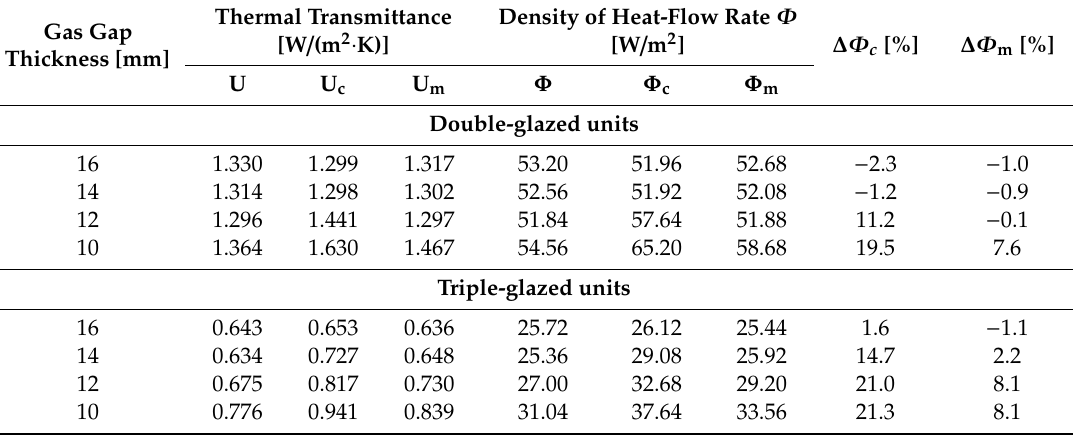
Table 5. Quantities describing heat losses by IGUs under conditions of reduced temperature (Variant 1) and atmospheric pressure increase by ∆ p = 3